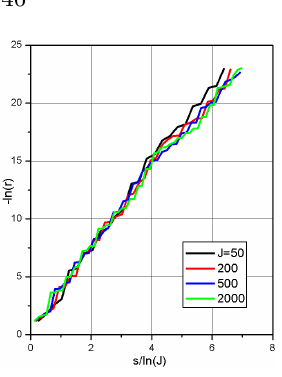
Figure 4. 5-solver, 9-scheme, Dirichlet, d-function.